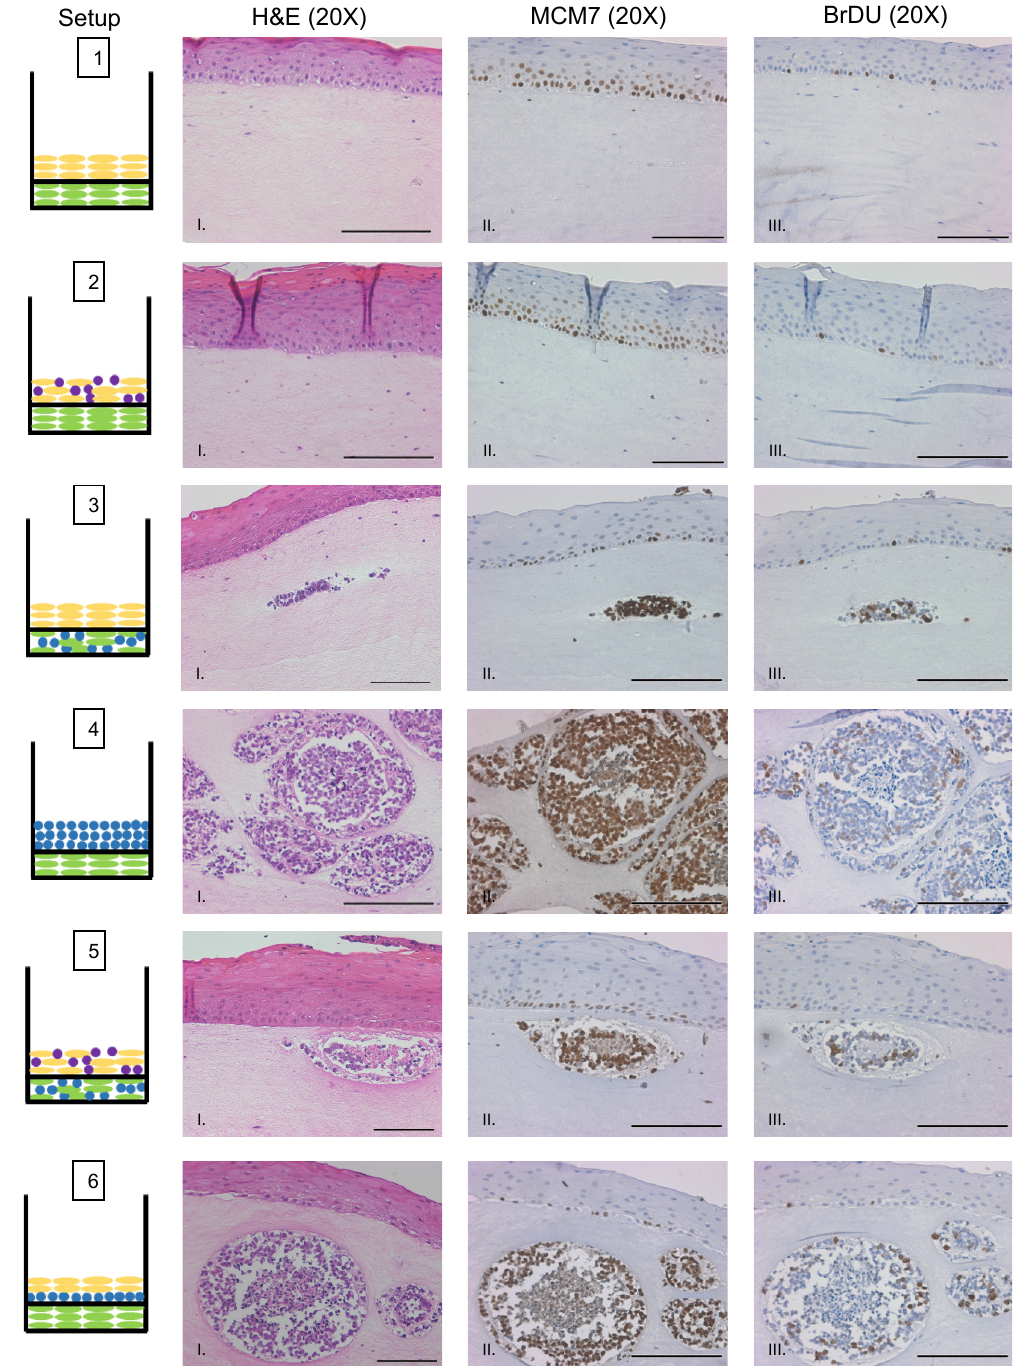
Figure 5. MCPyV+ MCC cells retain LT activity and proliferative capacity in organotypic raft cultures. Representative images showing immunohistochemical analysis for MCM7 (Panel II) and BrdU (Panel III) in raft setups are shown. Positive signal is indicated by brown nuclei staining. Counterstaining was done using hematoxylin (blue). Each raft setup is shown on the left and cell types are represented using the symbols outlined in Figure 1B. Corresponding H&E images are shown in Column I. All scale bars = 100 μ M.